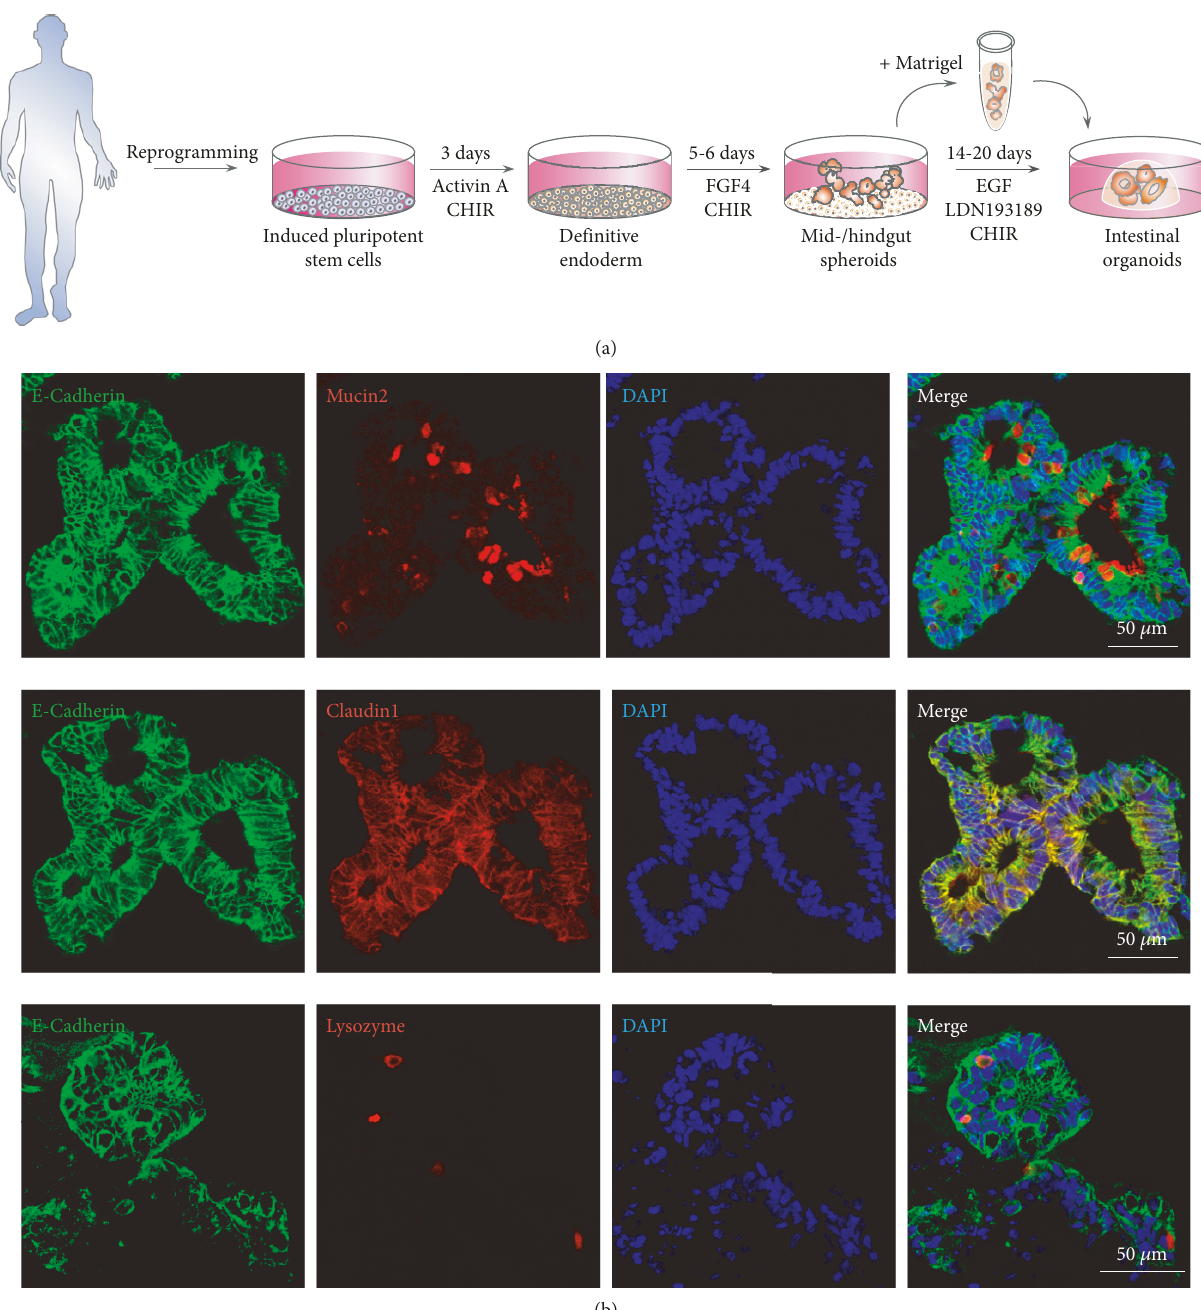
Figure 1: (a) Reprogramming of somatic cells towards induced pluripotent stem cells (iPSCs) and di ff erentiation of iPSC into intestinal organoids using di ff erent culture conditions. (b) Immuno fl uorescence staining of induced human intestinal organoids for essential markers of intestinal di ff erentiation. After evolution through the protocol shown in (a), organoids express mucin, claudin 1, and lysozyme together with